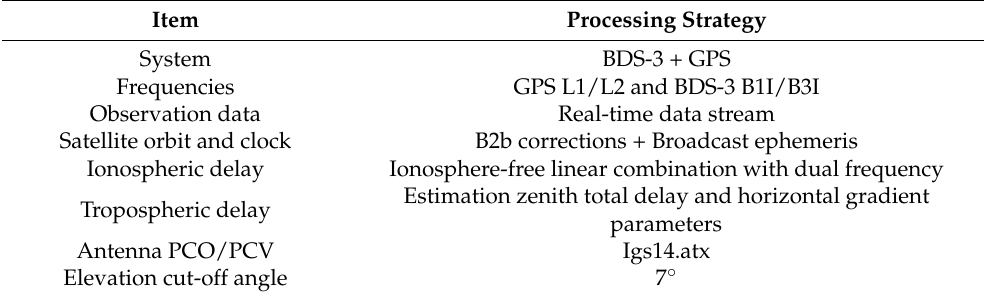
Table 4. Processing strategies for the simulated kinematic PPP-B2b experiment.